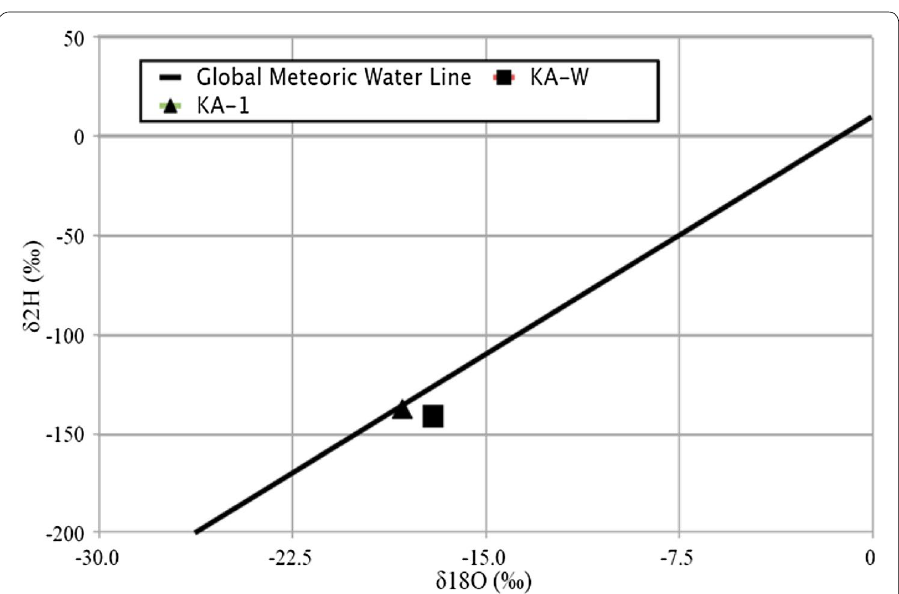
Fig. 5 Plot of deuterium and oxygen-18 for samples KA-1 and KA-W in comparison to the